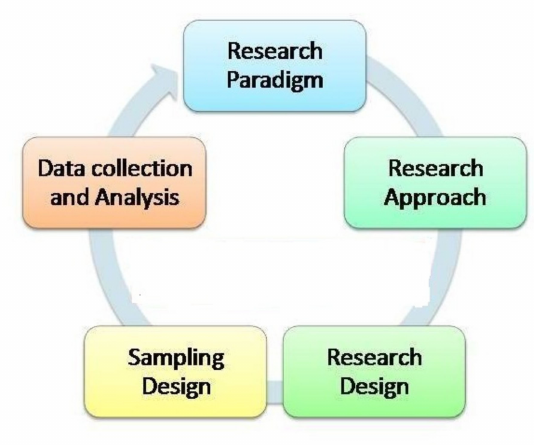
Figure 4. Adopted research